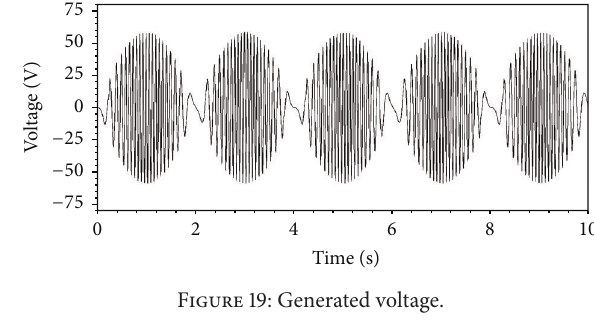
Figure 19: Generated voltage.